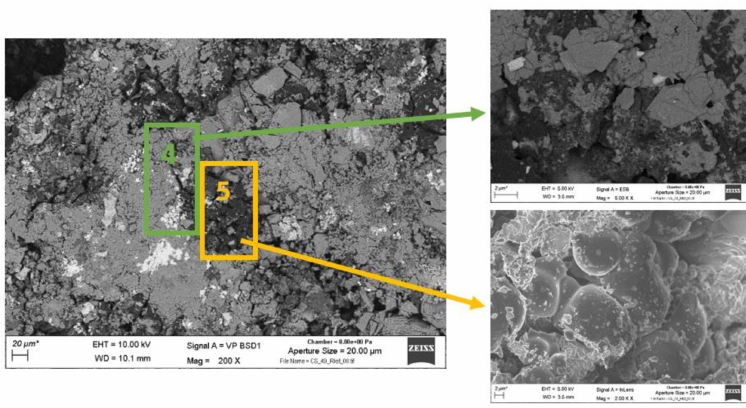
Figure 14. SEM recordings of solid deposits of experiment 6.